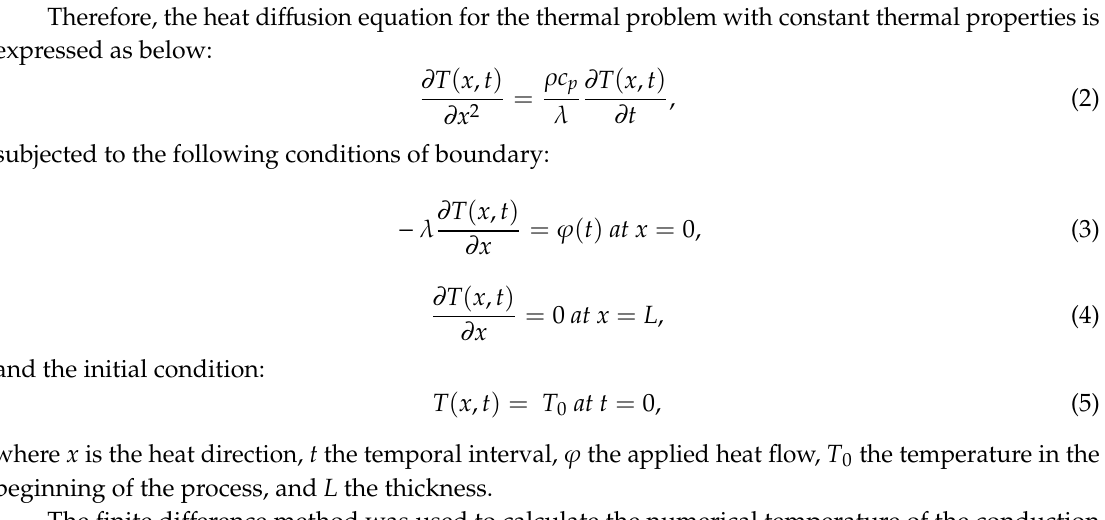
Figure 2. Experimental apparatus sketch used to estimate ρ c p and λ .